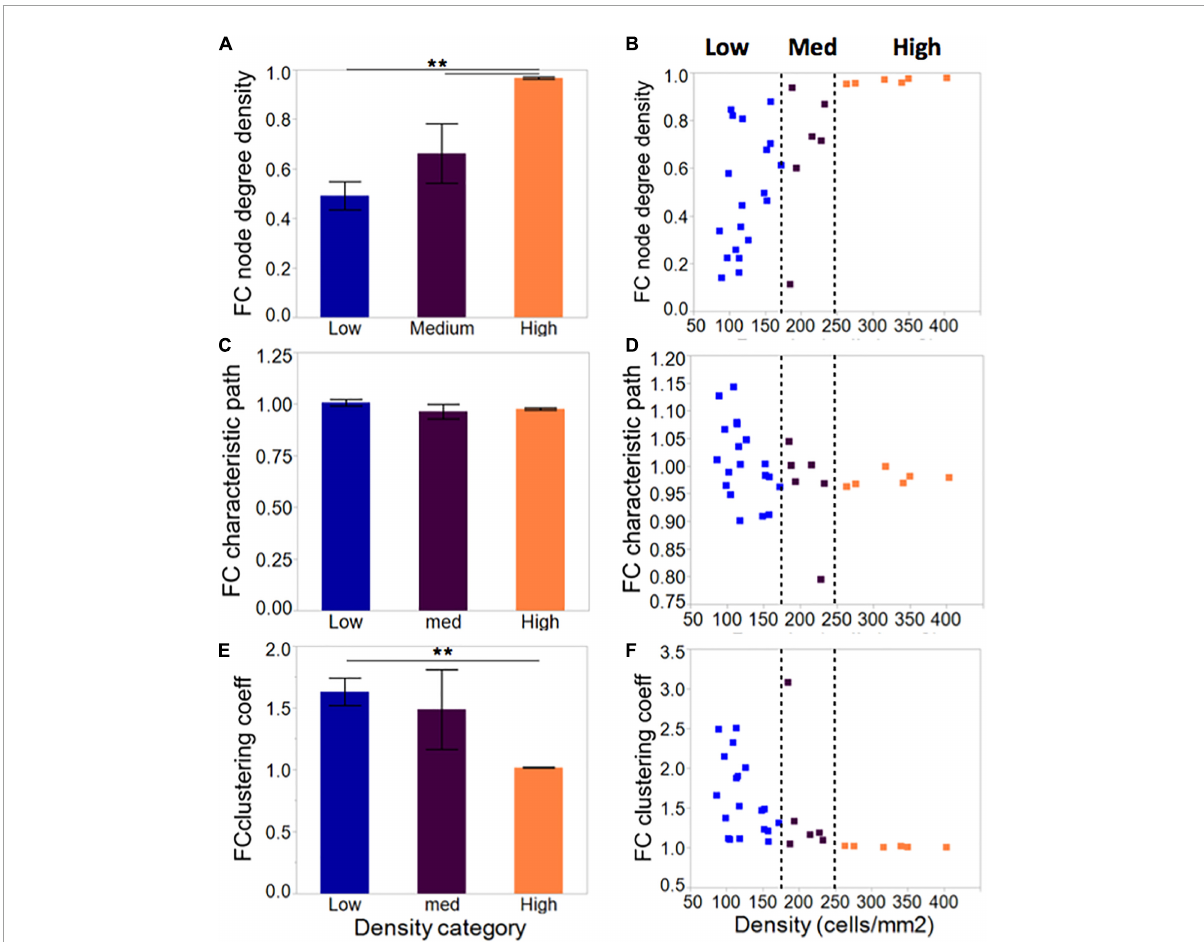
FIGURE6 Network metrics in neuronal islands of varying cellular densities. (A) Phase correlation-based functional connectivity was increased in islands of higher cellular density, pointing to more densely connected neurons within the high-density islands. All values were scaled to the total number of connections possible given a network’s size, such that all difference observed reflect increased connectivity rather than the increased availability of neighbors to connect to. This difference was accompanied by a corresponding reduction in clustering coefficient (E) , a measure of network segregation, but no significant difference in average characteristic path (C) , a measure of network integration. Both characteristic path and clustering coefficient were referenced to average values derived from size- and degree- matched random control networks for each island. Therefore, a value of 1 for characteristic path and clustering coefficient indicates that the network is very similar to a random one. (B,D,F) As for activity markers in Figure 4 , a cellular density threshold at 250 cells/mm 2 marked the transition between networks with highly variable characteristics (low cellular density islands) to networks with very well-defined properties (high cellular density islands). Significance level: ** p < 0.01.